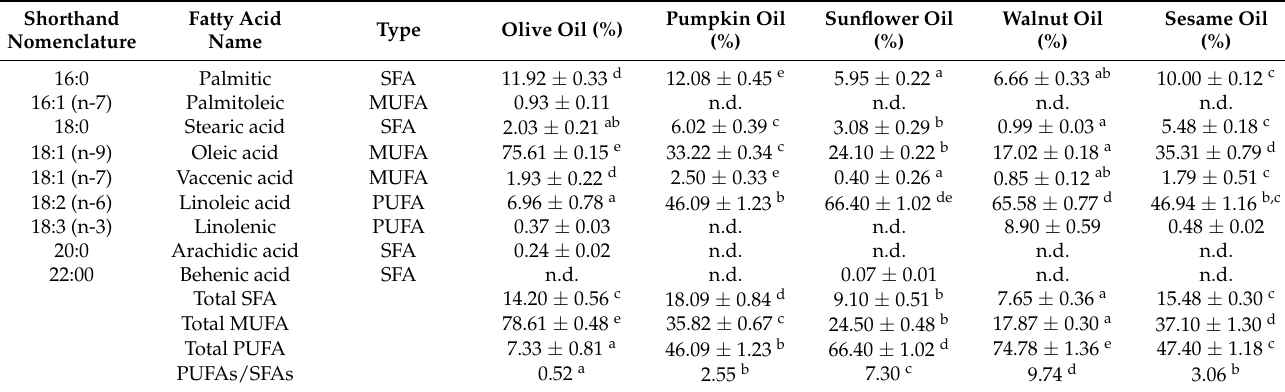
Table 3. Fatty acids and volatile profile composition of oils used for aging